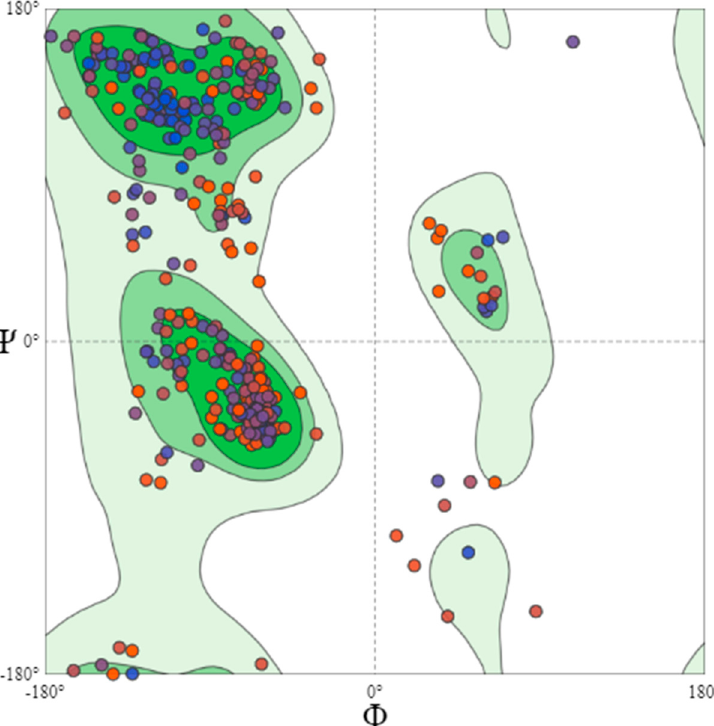
Figure 6. Ramachandran plot of Robetta-TR protein model (final model selected). The Ramachandran plot of modeled protein, representing 83.0% of residues in most favoured regions, 14.4% in additional allowed regions, 1.1% in generously allowed regions, and 1.5% in the disallowed regions.